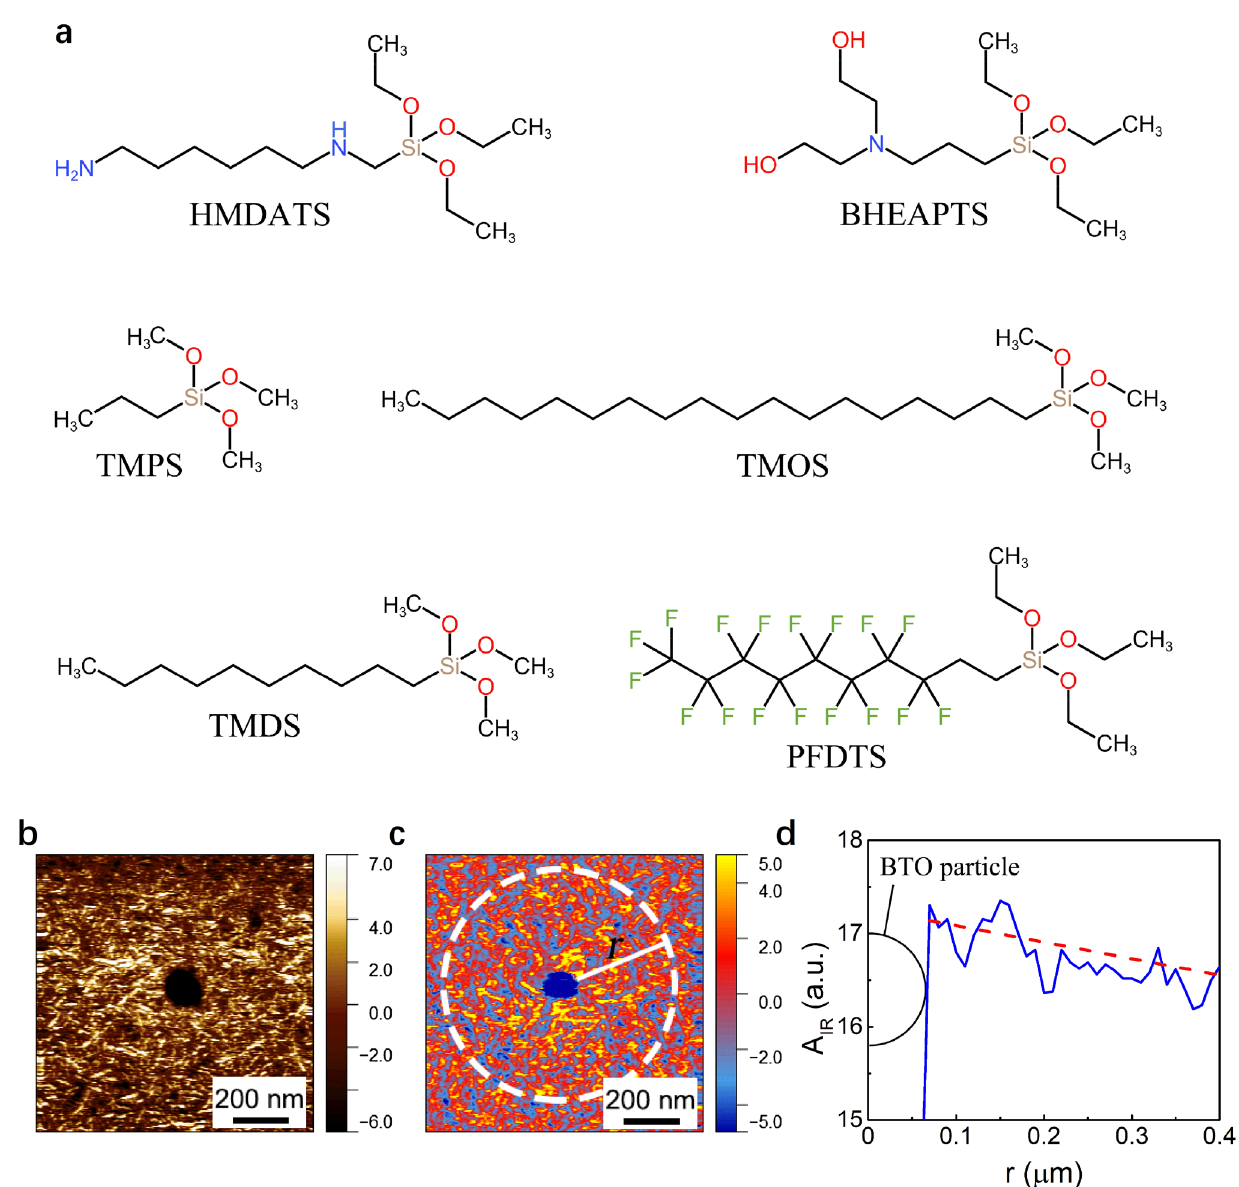
Fig. 2 a The chemical structures of silane coupling agents. b The PFM mapping and c Nano-IR mapping at 1288 cm. −1 of